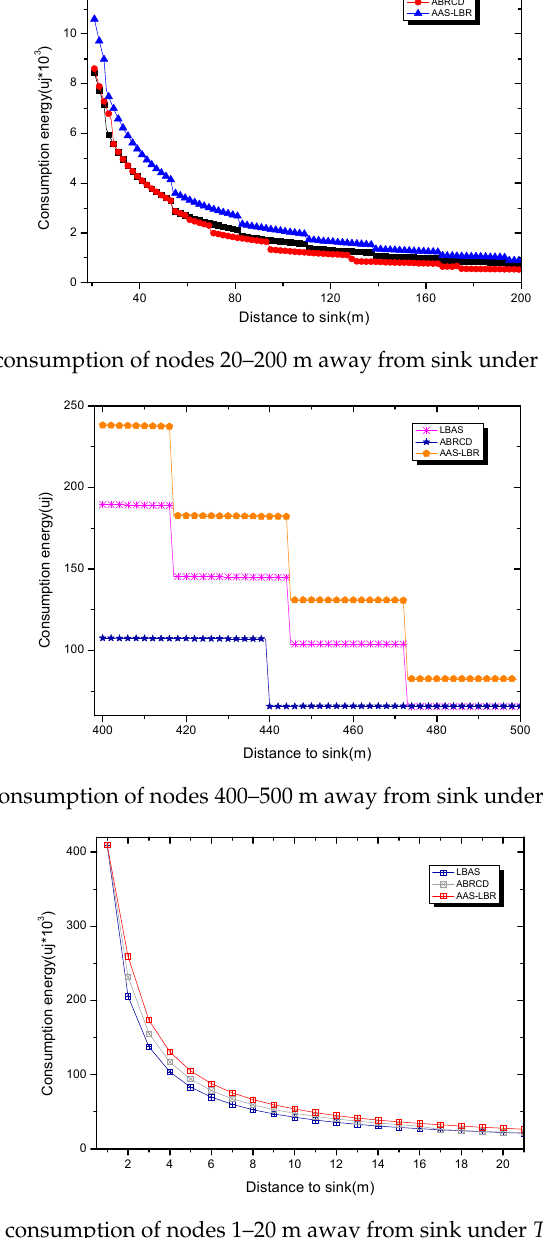
T = 60 and r = 28 Figure 28. Energy consumption of nodes 1–20 m away from sink under 𝑇 = 60 and r = 28 m . Figure 28. Energy consumption of nodes 1–20 m away from sink under Figure 28. Energy consumption of nodes 1–20 m away from sink under 𝑇 = 60 and r = 28 m . Figure 28. Energy consumption of nodes 1–20 m away from sink under 𝑇 = 60 and r = 28 m . Figure 28. Energy consumption of nodes 1–20 m away from sink under 𝑇 = 60 and r = 28 m .